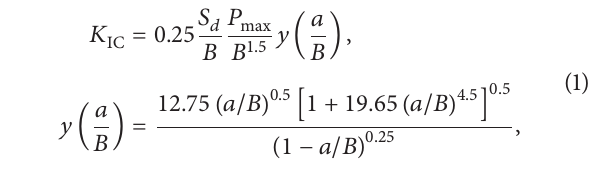
by 5 cm. The specimens were taken out every month to measure the P-wave velocity and test the fracture